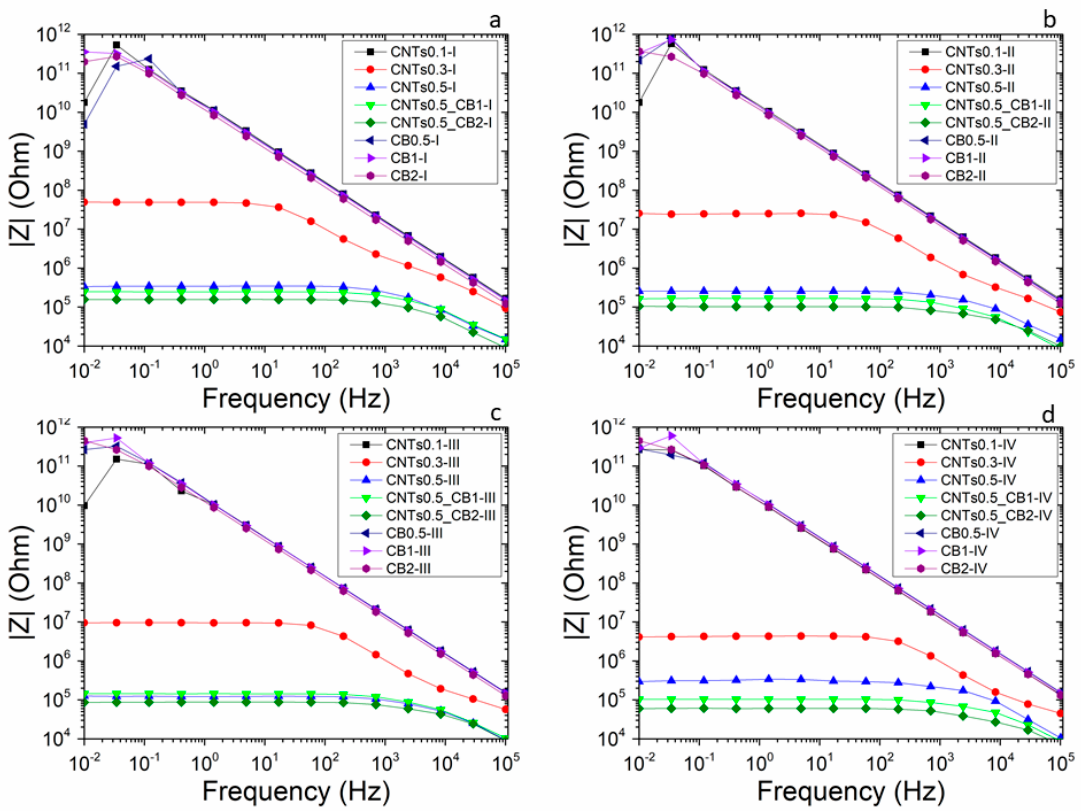
Figure 2. Bode plots of binary and ternary systems for ( a ) 1, ( b ) 2, ( c ) 3 and ( d ) 4 h of dispersion process.